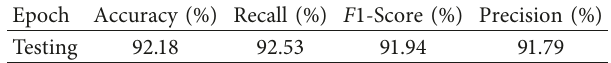
Table 10: Test results of the model’s dataset I.